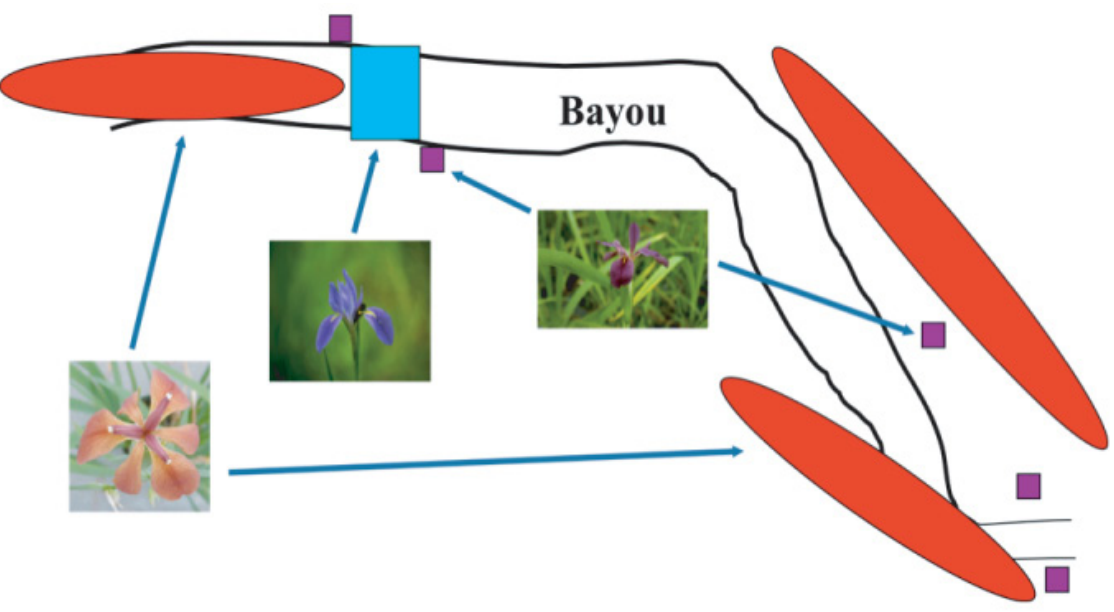
(red ovals), 2) introduced I. hexagona (blue rectangle) and 3) I. fulva x I. hexagona F plants (purple squares)